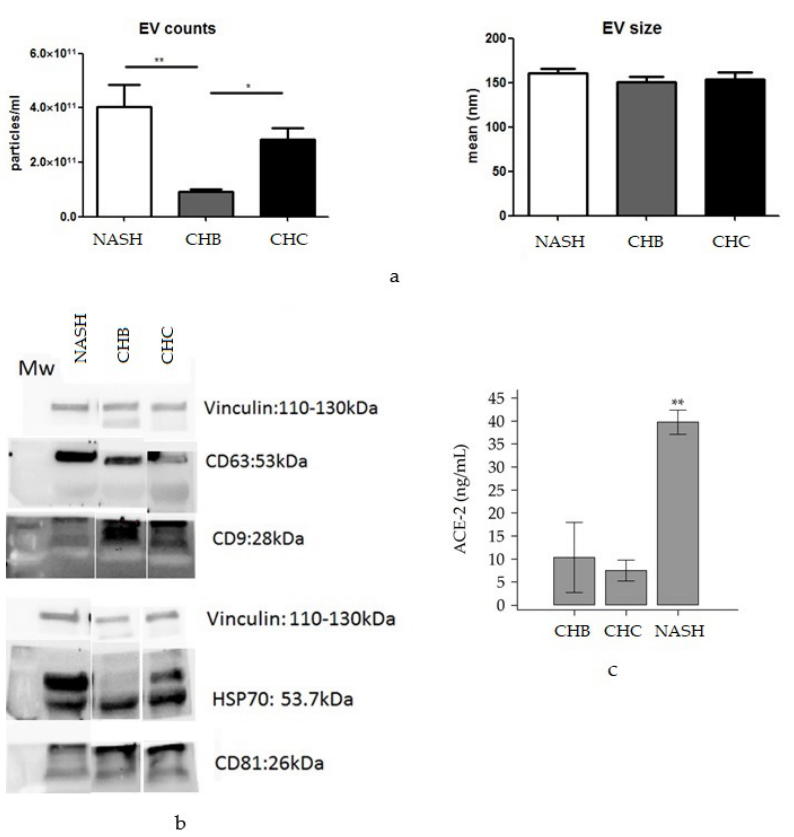
Figure 2. EV counts and dimensional distribution of hepatic EV according to etiology ( a ). Western blot analysis of EV markers CD63, CD9, HSP70 and CD81 expression, normalized according to Vinculin expression ( b ). EV, extravesicles; MW, molecular weight marker; NAFLD, non-alcoholic fatty liver disease. ( c ) Circulating levels of ACE2 in plasma of CHB, CHC and NAFLD patients. The image shows the circulating ACE2 levels (ng/mL) in the plasma of patients with liver disease of different etiology. Circulating ACE2 was significantly higher in NAFLD subjects compared to CHB and CHC patients ( p = 0.0019). * p < 0.05; ** p < 0.005.